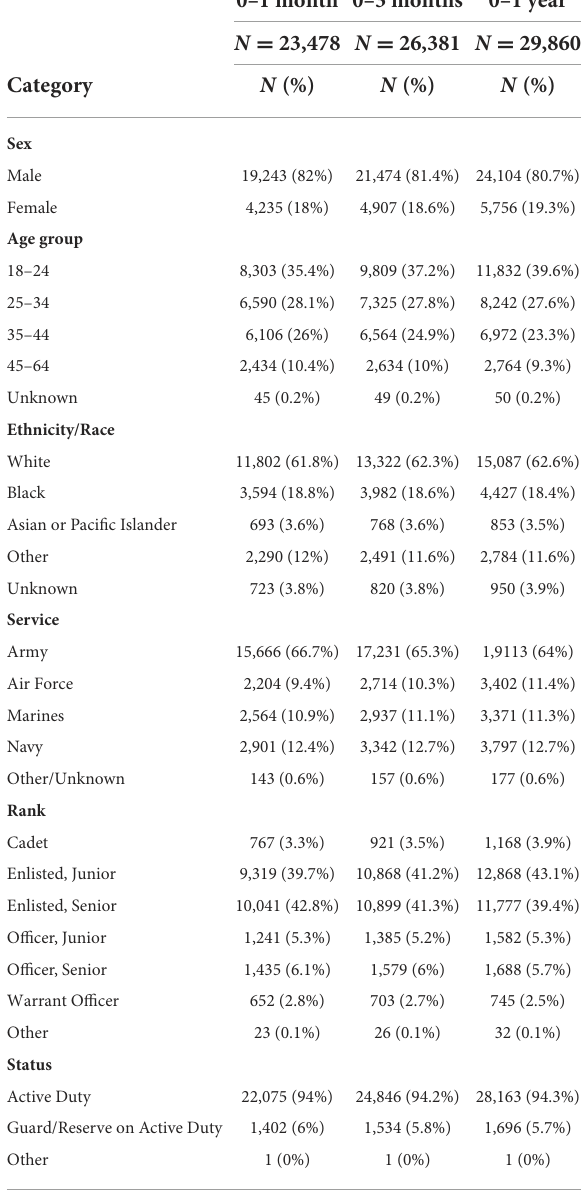
TABLE 1 Demographic characteristics across time for mTBI